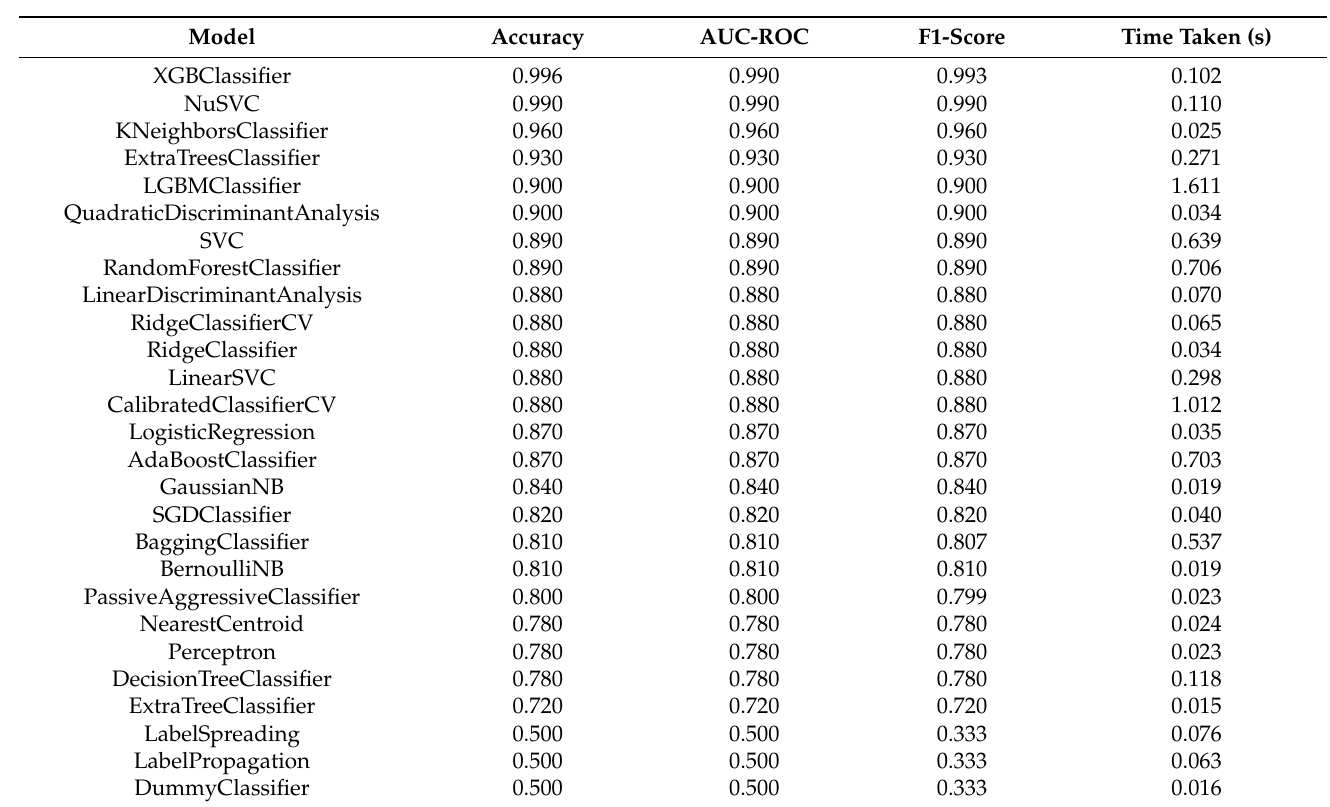
Table 1. Evaluation of 27 Classifiers on the Original